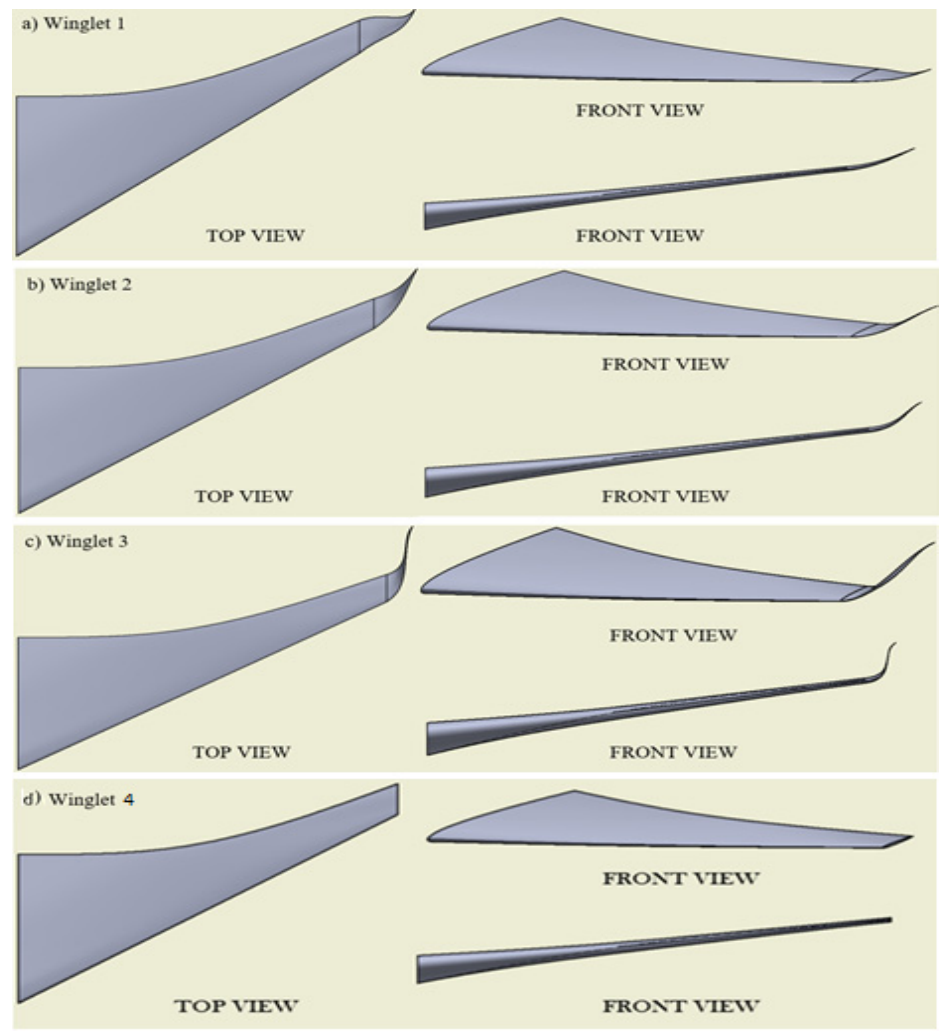
Figure 2. Winglet designs ( a ) 20° cant angle, extending 4 m from main wing, height of 1 m ( b ) 45° cant angle, extending 3 m, with a height of 2 m ( c ) 65° cant angle, extending 2 m, with a height of 3 m ( d ) 0° for the Boeing 787-9 Dreamliner wing. Table 1. Details of the Freighter aircraft. Parameter Value Total wingspan 60 m Root chord length 13.5 m Speed range 1350 km Take-off weight 254,011 kg Take-off speed chosen 82